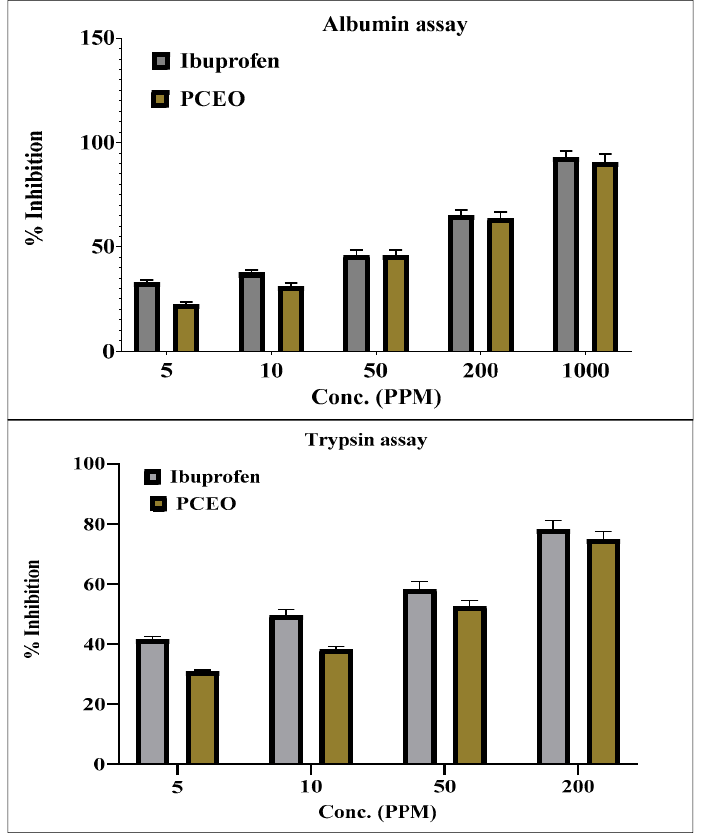
Figure 2. Anti-inflammatory activity of P. crispum leaves essential oil (PCEO).